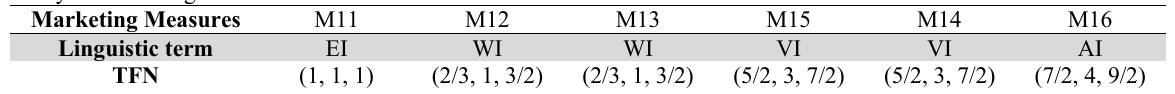
Fuzzy Comparative